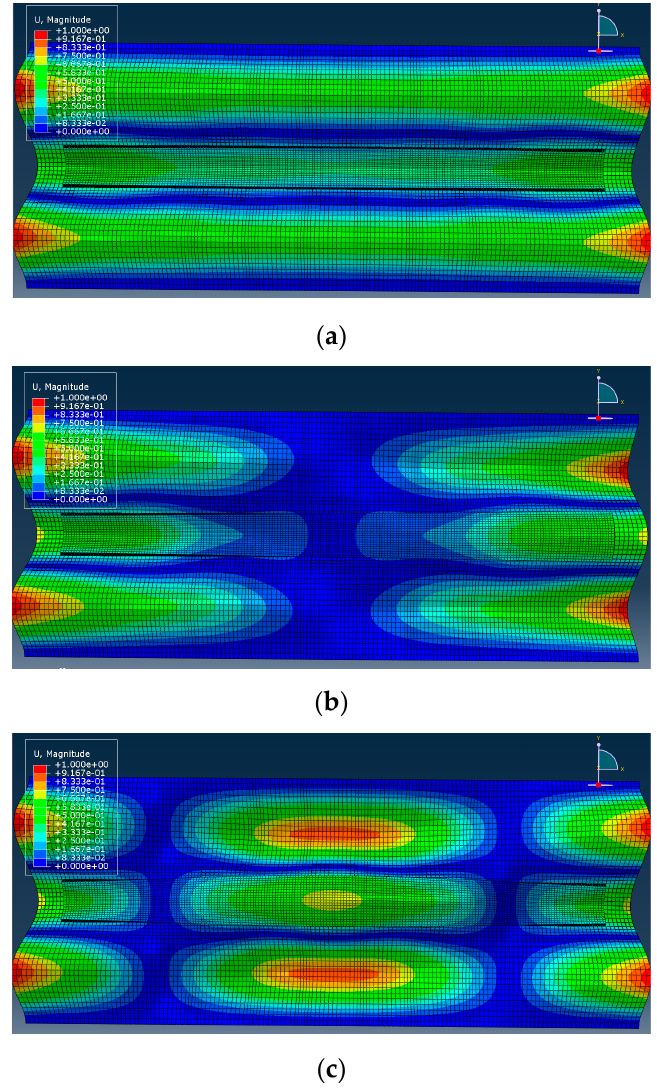
Figure 11. Mode 17 ( a ), mode 18 ( b ) and mode 20 ( c ) predicted by the frequency analysis of the numerical model.